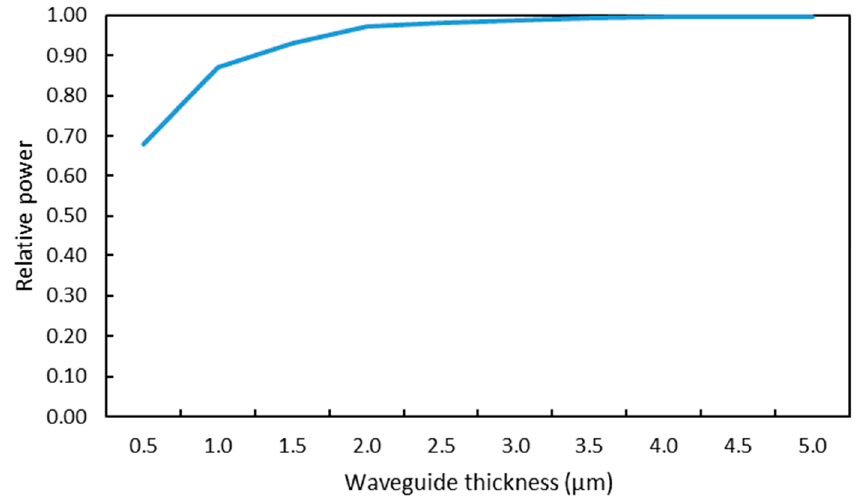
Figure 4. Relative optical power as a function of waveguide thickness for the 4 µm waveguide width.